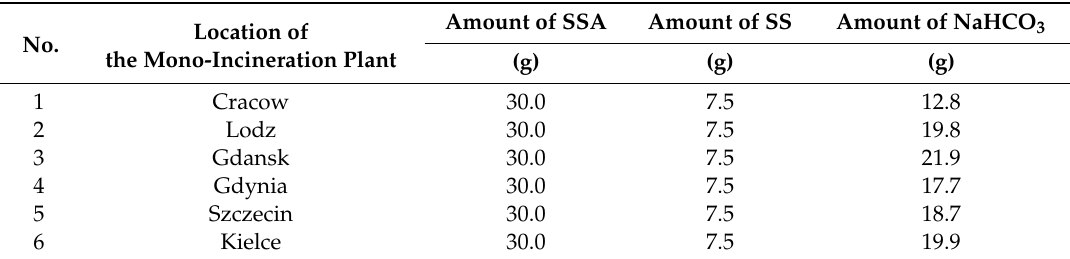
Table 2. The amounts of the SSA, SS and NaHCO 3 mixed in the individual experiments. No.